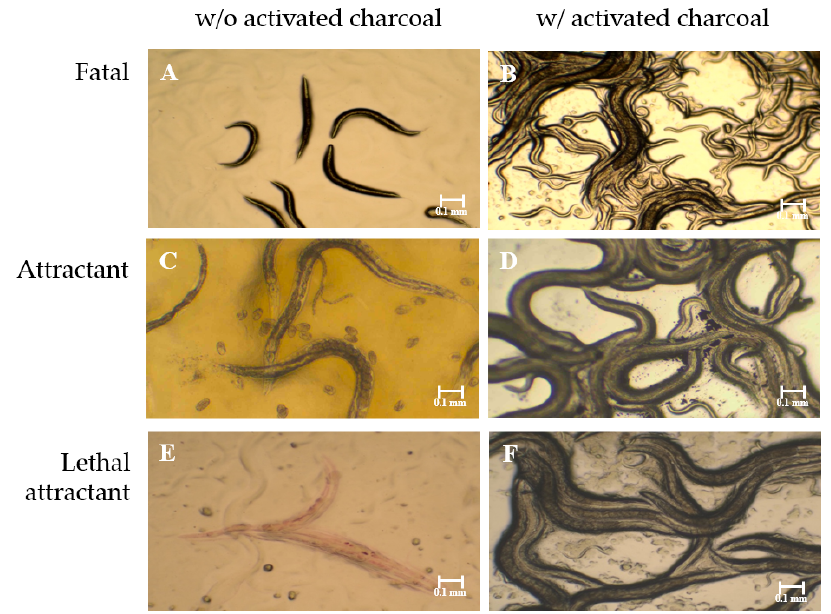
Figure 1. Exemplified fumigant activity of VOCs emitted by screened bacteria toward C. elegans . ( A ) The worms were immobilized after fumigation with VOCs emitted by B. gladioli grown on LB agar. ( B ) Same treatment as ( A ) but with activated charcoal. ( C ) The worms were lured to D. yeojuensis cultivated on LB agar and laid eggs. ( D ) Same treatment as ( C ) but with activated charcoal. ( E ) The worms were lured to S. marcescens cultivated on LB agar and died afterward. ( F ) Same treatment as ( E ) but with activated